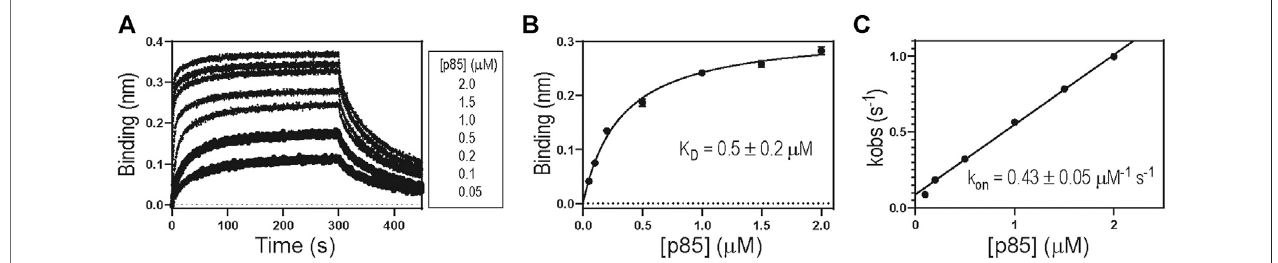
FIGURE3 | (A) A representative BLI sensorgram showing binding between 1918NS1 WT and p85 β . Representative (B) binding isotherm and (C) binding kinetics between 1918 NS1 WT and p85 β